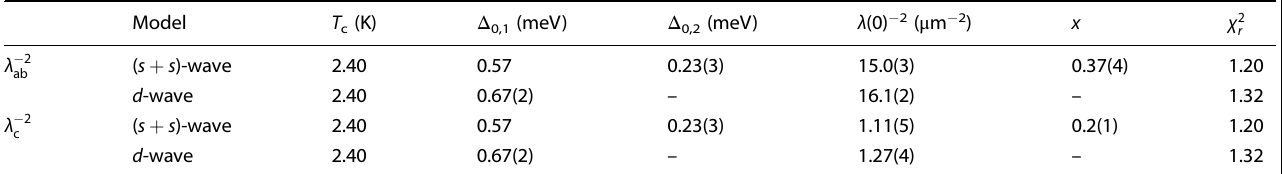
Table 1. Superconducting parameters determined from fi ts to the temperature dependence of λ ( T ) derived from TF- μ SR experiments, using an ( s + s )-wave and a d -wave model. Here χ 2 represents the reduced χ 2 values for different fi t r